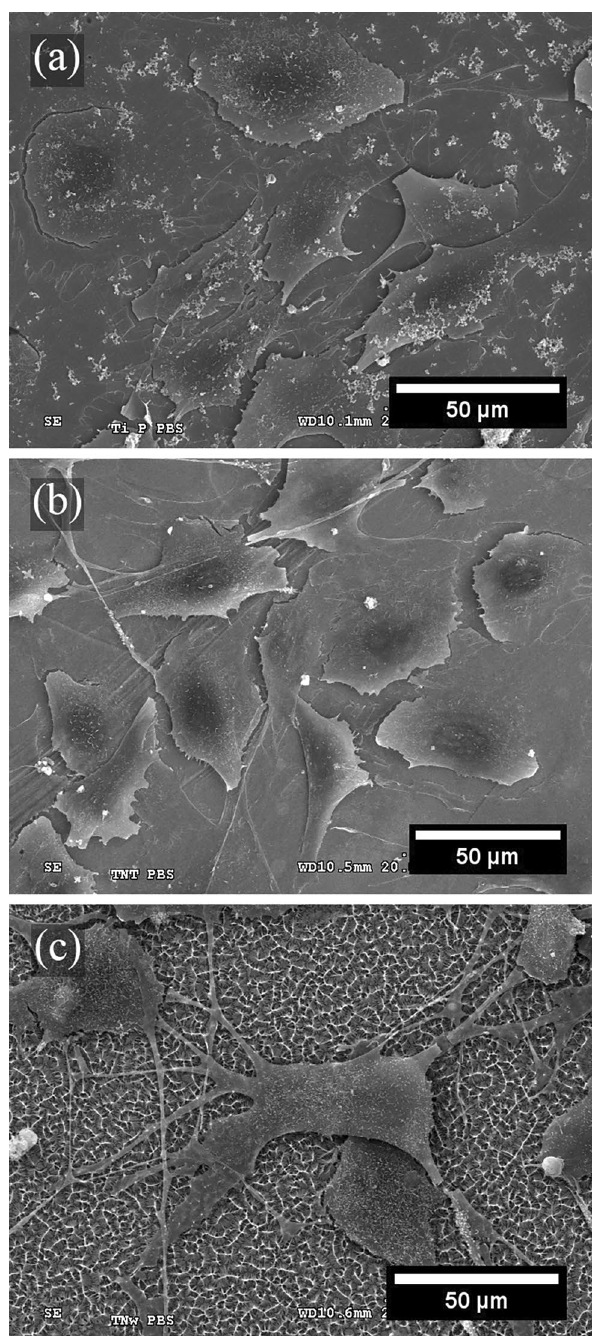
Figure 8. Scanning electron micrographs of MC3T3-E1 cells after 48 h of culture. ( a ) Flat TNZT, ( b ) TNTs, and ( c )